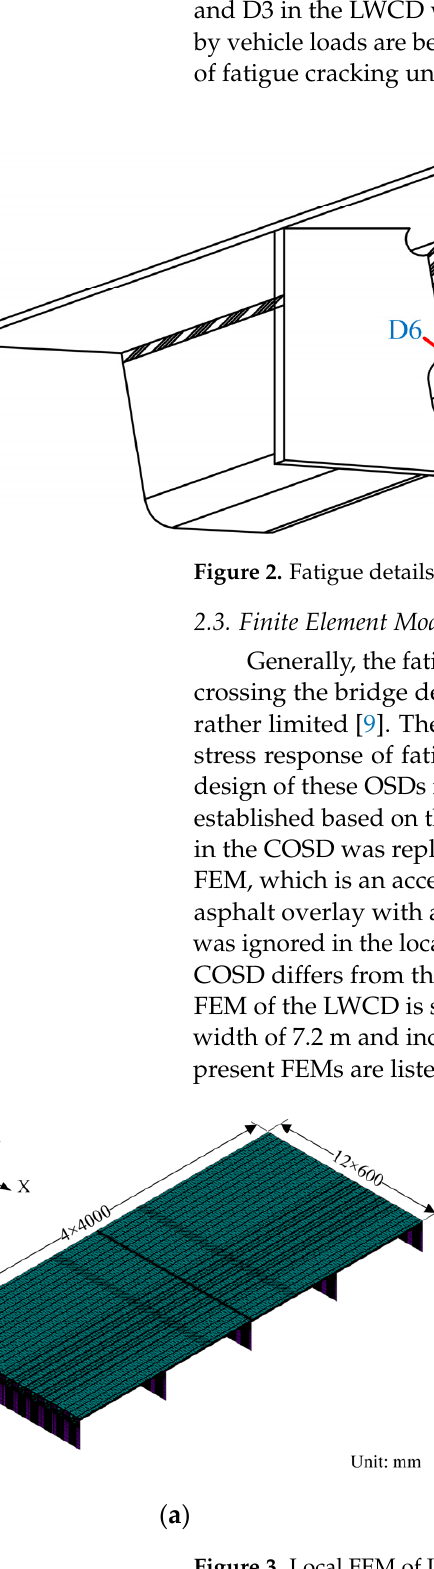
Figure 3. Local FEM of LWCD: (a) Full view of FEM; (b) Detail view of interest.